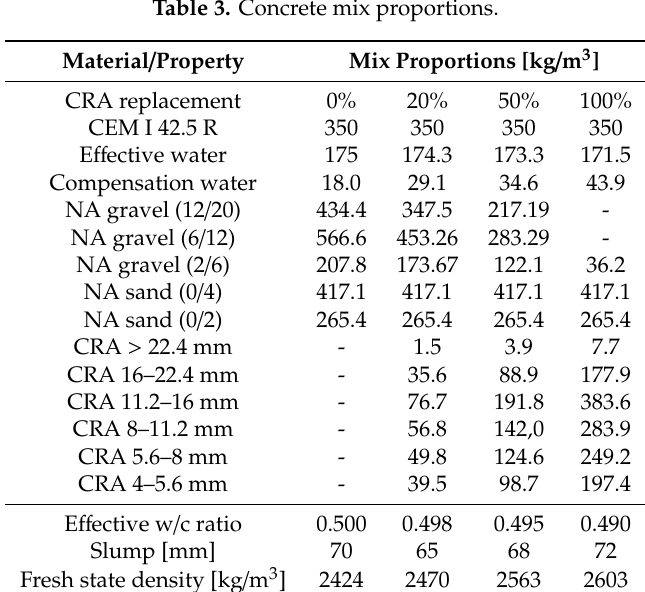
Figure 1. Theoretical curve and grading of the different aggregates according to EN 933-1.